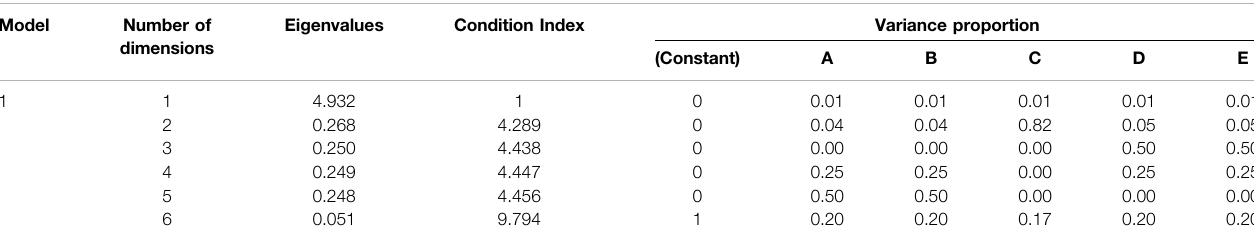
TABLE 6 | Collinearity diagnostic parameters.